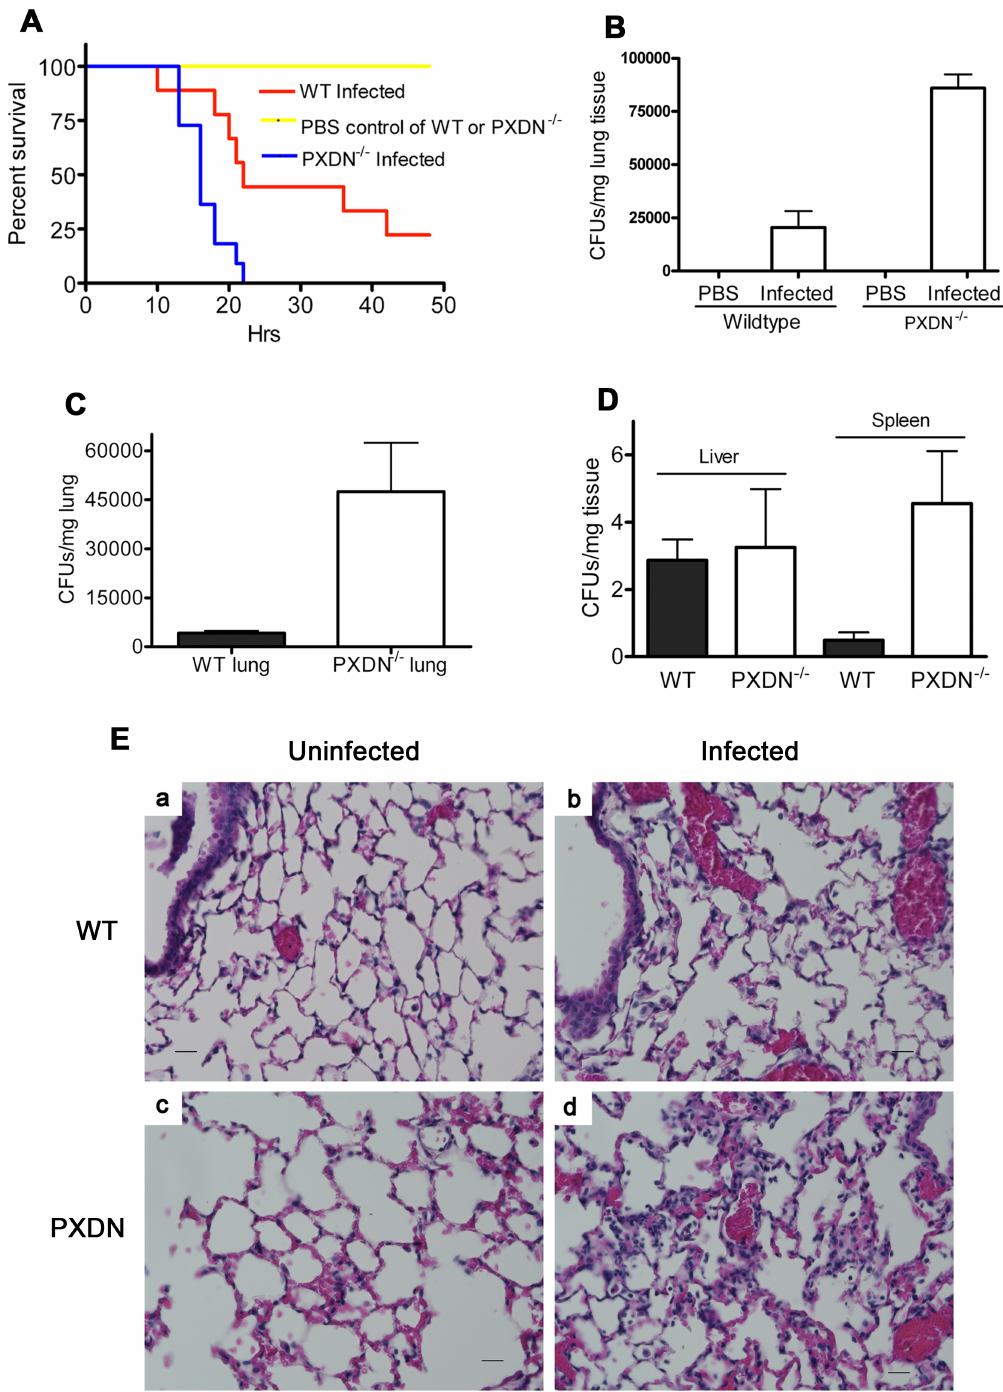
Fig 5. PXDN mutant mice reveal impairment in bacterial clearance during acute lung infection. (A) Decrease of relative survival rates. PXDN-deficient and C57BL/6 wild-type mice were intratracheally instilled with 7 x 10 6 of P . aeruginosa strain K or PBS control. Relative survival rates were determined over a period of 48 hours; n = 9–11 per group, P = 0.0068. (B) Lung Bacterial burden. Mice were sacrificed at 20 hours; lungs were aseptically removed, weighed, and homogenized in PBS. Lung tissue suspension was serially diluted and plated on LB agar plates. After incubation at 37˚C for 18 h, CFUs were counted and CFUs/mg tissue were calculated; n = 12 from 4 mice per group; one-way analysis of variance, P < 0.0001 for all comparisons. (C and D) Tissue burden on bacterial infection with sublethal dose was carried out by intratracheally infecting the mice with 3 x 10 6 of P . aeruginosa strain K. After 20 h, lung, liver and spleen were taken as in (B) for detection of bacteria. n = 15–21 from